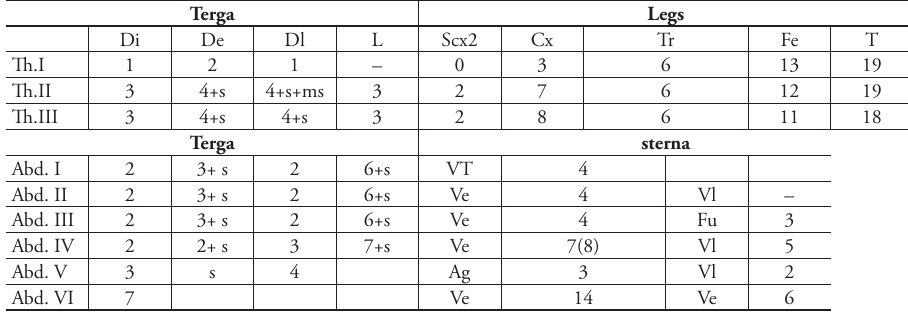
Table 2b. Body tubercles and chaetotaxy of Paralobella tianmuna sp.